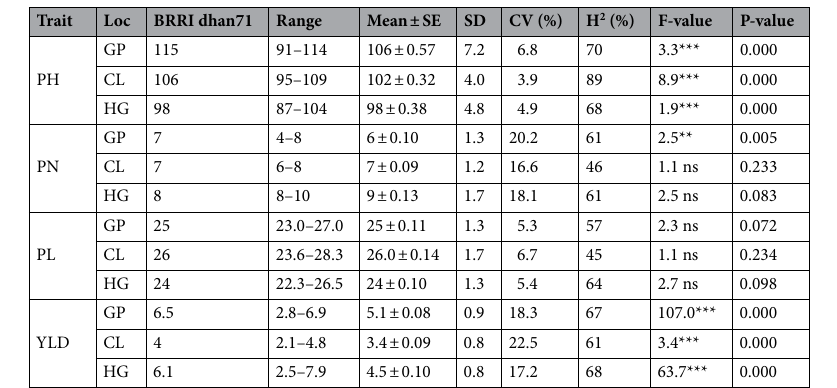
Table 5. Multi-location evaluation of BRRI dhan71 ILs in Bangladesh. PH—plant height (cm), PN—panicle number, PL—panicle length (cm), YLD—yield (t/ha), SE—standard error, SD—standard deviation, CV— coefficient of variation (%), H 2 —heritability, GP—Gazipur, CL—Cumilla, HG—Habiganj. ** P≤0.01, *** P≤0.001.